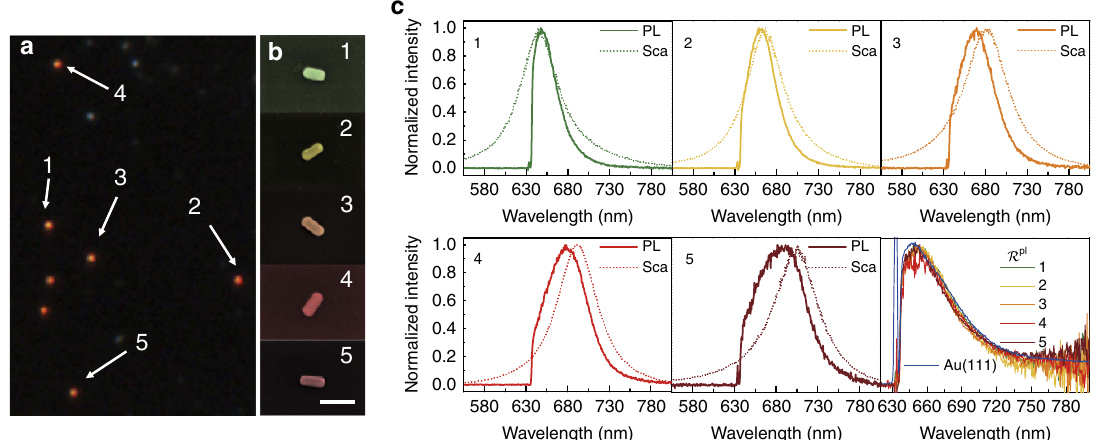
Figure 2 | Correlation of the PL and LSPR scattering for single gold nanorods. ( a ) Dark-field scattering image of the sample, where the five nanorods with LSPRs at different wavelengths are marked by arrows. ( b ) SEM images of the nanorods indicated in a in pseudo color. Scale bar, 200nm. ( c ) 1–5: normalized PL spectra (solid lines) excited at 633nm and elastic scattering spectra (dotted lines) excited with a white light source, for the five nanorods selected in a , b . Bottom right panel: Normalized ratio of the PL spectra to the scattering spectra, R pl , of these five nanorods (labeled 1–5) and the PL spectra of a gold(111) single-crystal surface normalized by the value at 648nm (blue